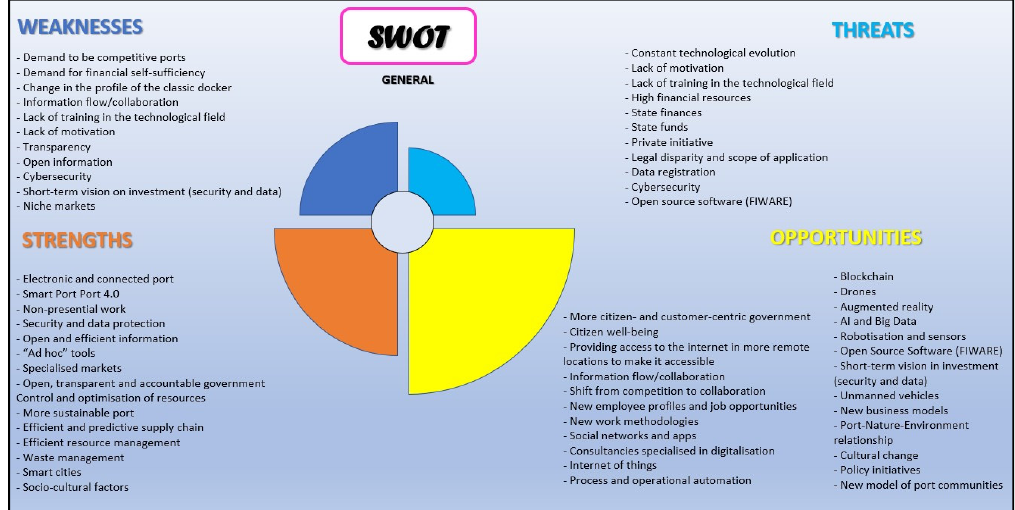
Figure 7. BOT indicators in each element of the SWOT. Source: own elaboration. The indicators obtained with the BOT were applied to a SWOT matrix.